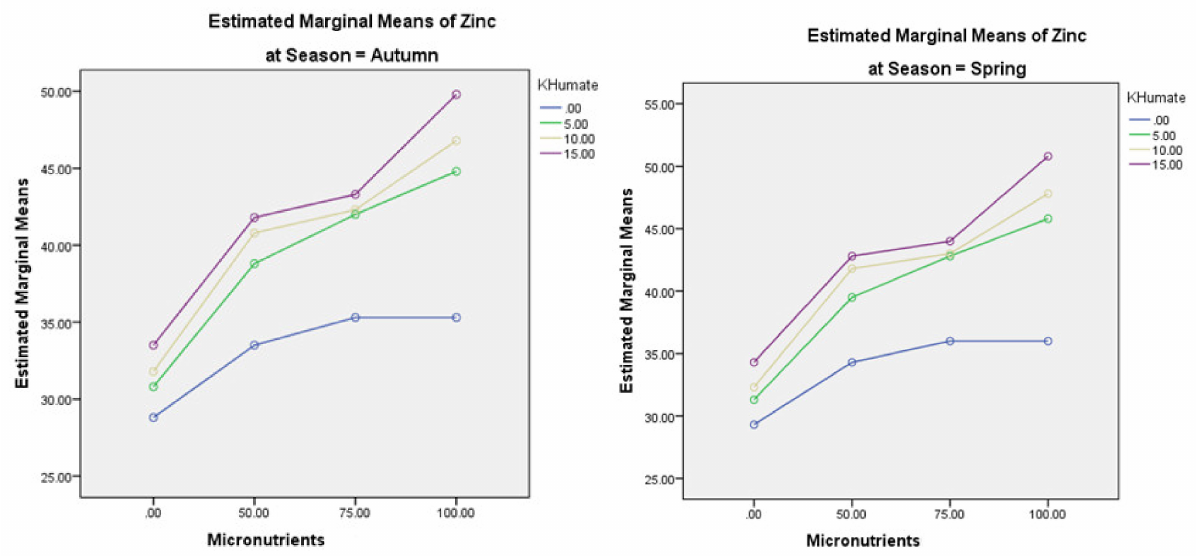
Figure 4. Interaction graphs for zinc concentration obtained in tomato fruit under K-humate and micronutrients mixture applied in the autumn and spring seasons. Table 6. Effect of the boron concentration (mg kg − 1 ) in the tomato fruit by various K-humate and MC levels under the field conditions during